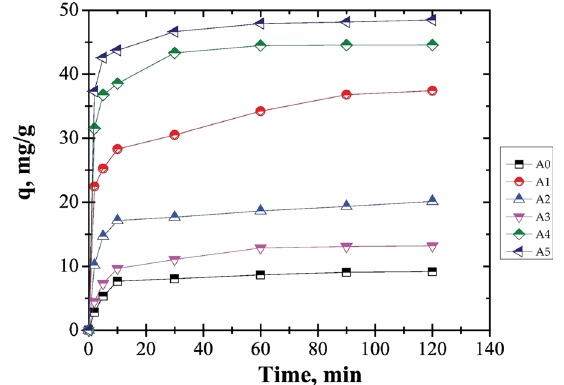
Fig. 21 Removal of Cd 2+ ions from water by CFA and modified CFA (Buema et al.